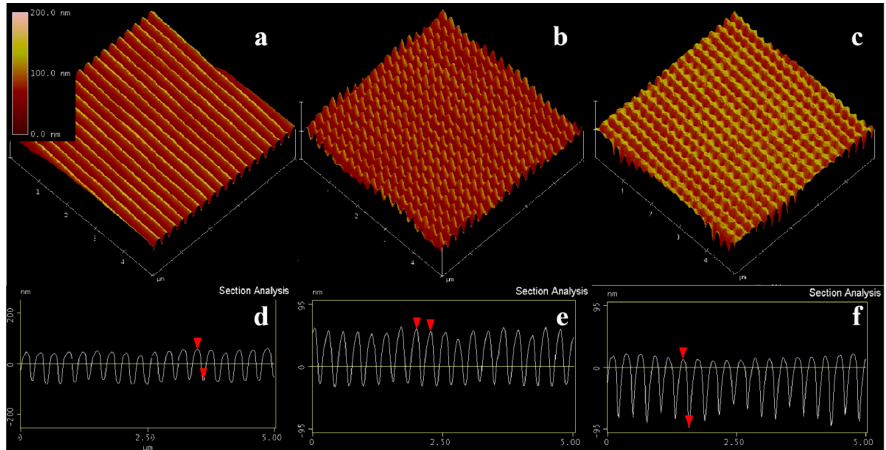
Figure 4. SEM pictures of gratings, dot, and hole arrays of the photoresist on PDMS–ITO substrate. The pictures are magnified by 40,000 times. The period of the grating ( a ) is about 273 nm. The diameter of the dot ( b ) and hole arrays ( c ) is 175 nm and 165 nm, respectively. The dot and hole arrays are made by rotating the sample holder 90° after the first exposure, and the different energy distribution leads to different nanostructures.